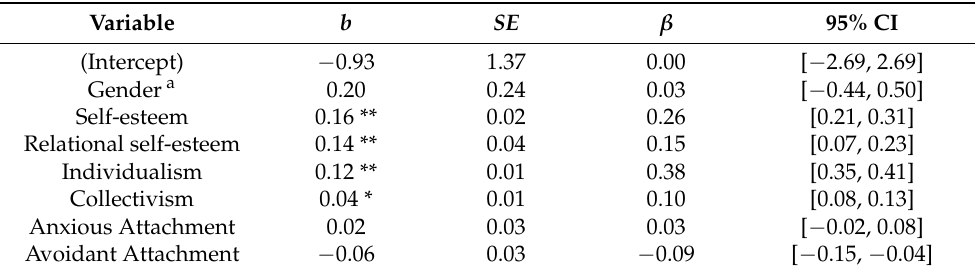
Table 2. Regression Coefficients of Study Variables on Internal